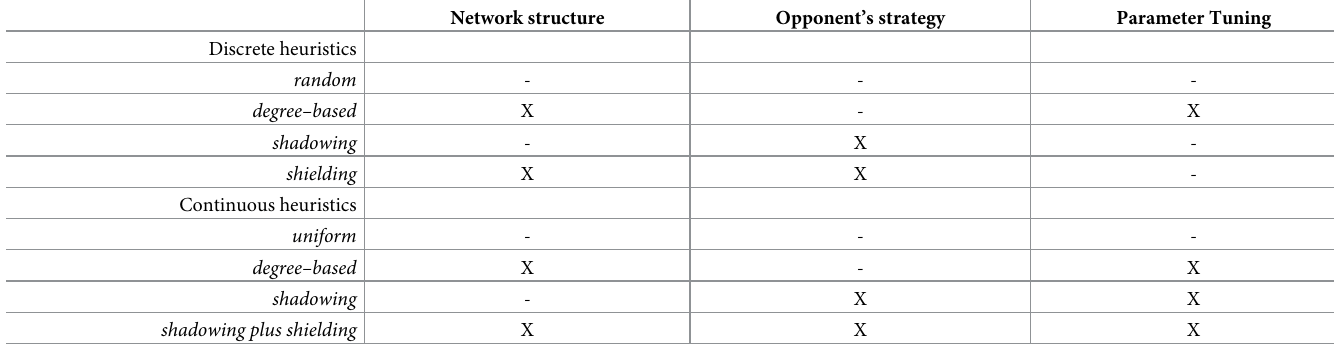
Table 1. Information required by each